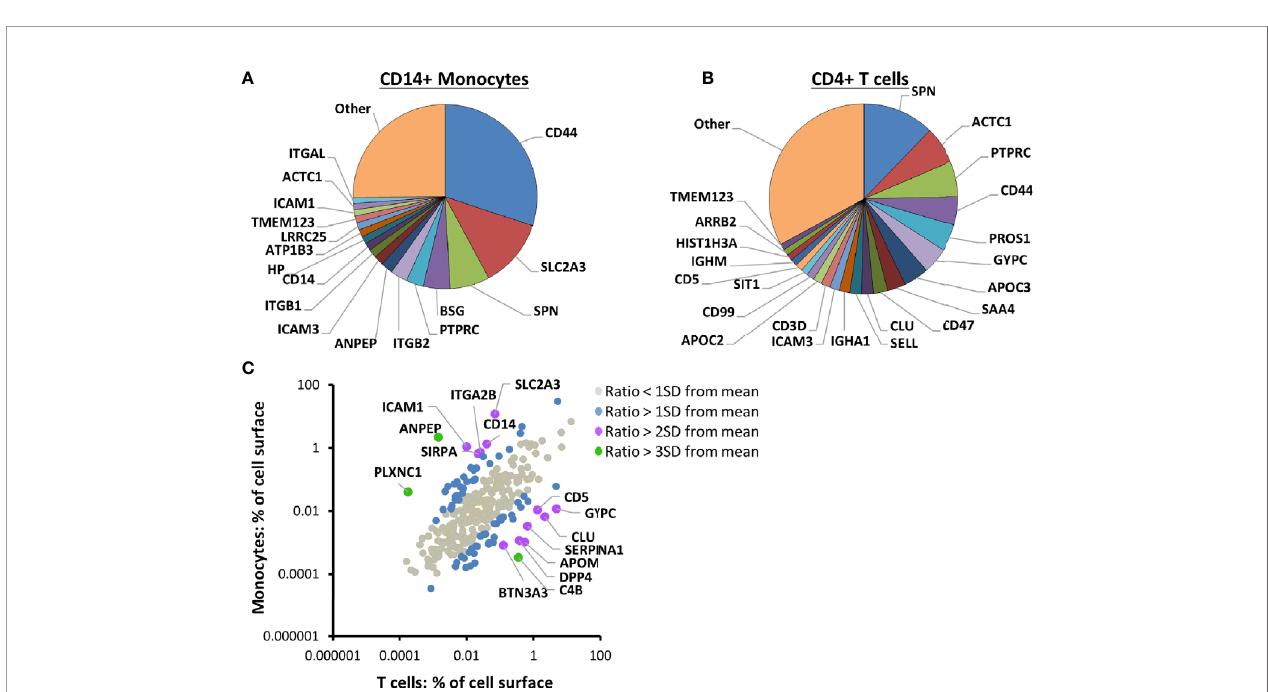
FIGURE 2 | Proteomic cell surface map of primary CD14+ monocytes and CD4+ T cells. (A) Pie chart of the relative contribution of individual proteins to the plasma membrane (PM) proteome of unstimulated primary CD14+ monocytes. iBAQ abundance values for each protein were estimated from the sum of the maximum precursor intensity for all contributing peptides divided by the theoretical number of tryptic peptides between 7 – 30 amino acids in length. The value was scaled according to the signal detected in the fi ve unstimulated samples compared to the total signal in all ten IFN-stimulated and unstimulated samples, to give an estimate of the protein expression at the surface of unstimulated cells. Classical class I and II MHC molecules were excluded from all iBAQ analyses to eliminate bias introduced by differentially expressed alleles between different donors. Proteins contributing less than one percent are grouped into ‘ other ’ . The complete dataset is given in Tables S1 and S3A . (B) Pie chart of the relative contribution of individual proteins to the PM proteome of unstimulated primary CD4+ T cells, calculated and displayed as described in (A) . The complete dataset is given in Tables S1 and S3B . (C) Comparison of the contribution of 280 proteins to the PM proteome of unstimulated primary CD14+ monocytes and CD4+ T cells. Classical class I and II MHC molecules were excluded as described in (A) . Color coding illustrates the number of standard deviations (SD) from the mean for each protein ’ s log 2 ratio (% PM proteome (CD14+ monocytes)/% PM proteome (CD4+ T cells)). The complete dataset is given in Tables S1 and S3C